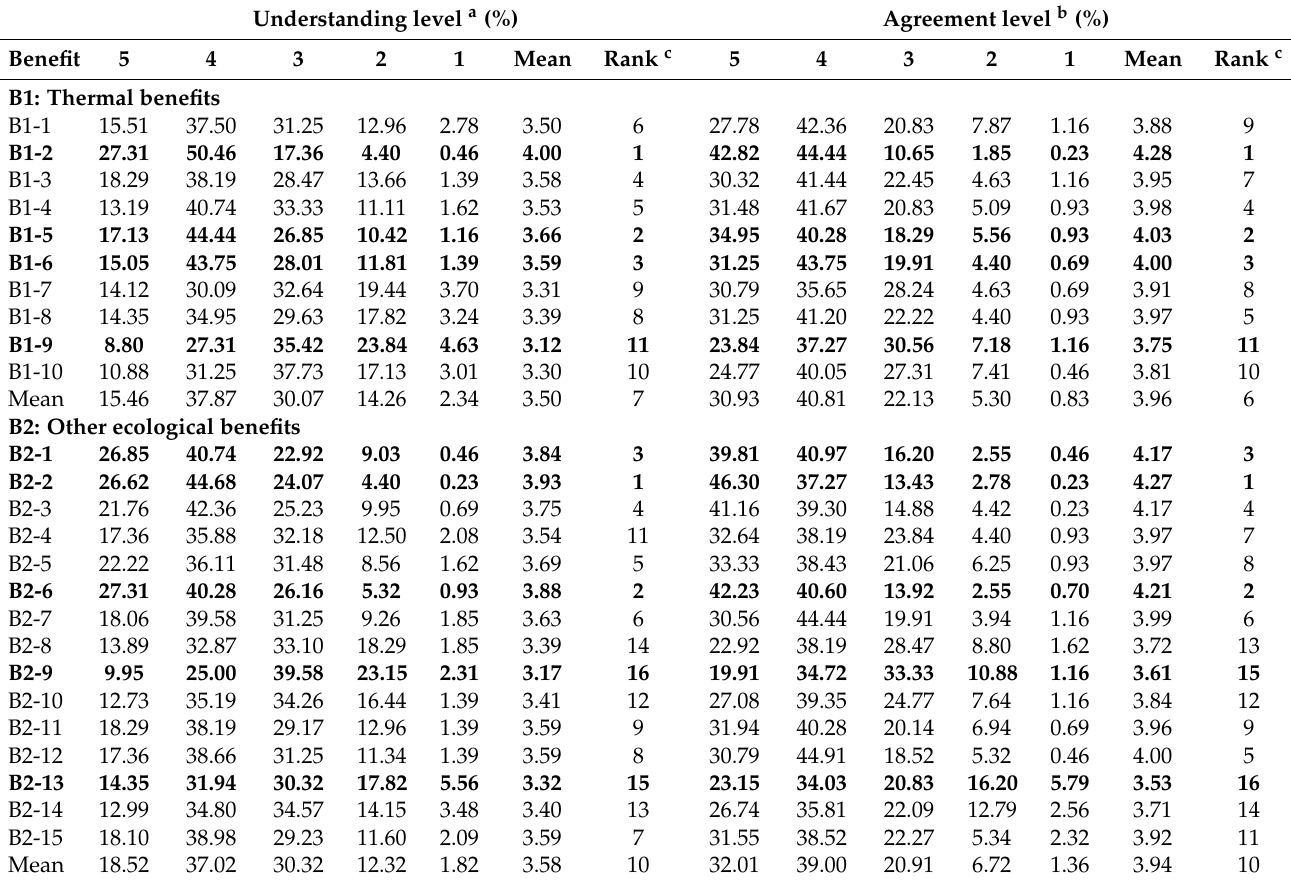
Table 4. Understanding and agreement levels of respondents on UGS ecological